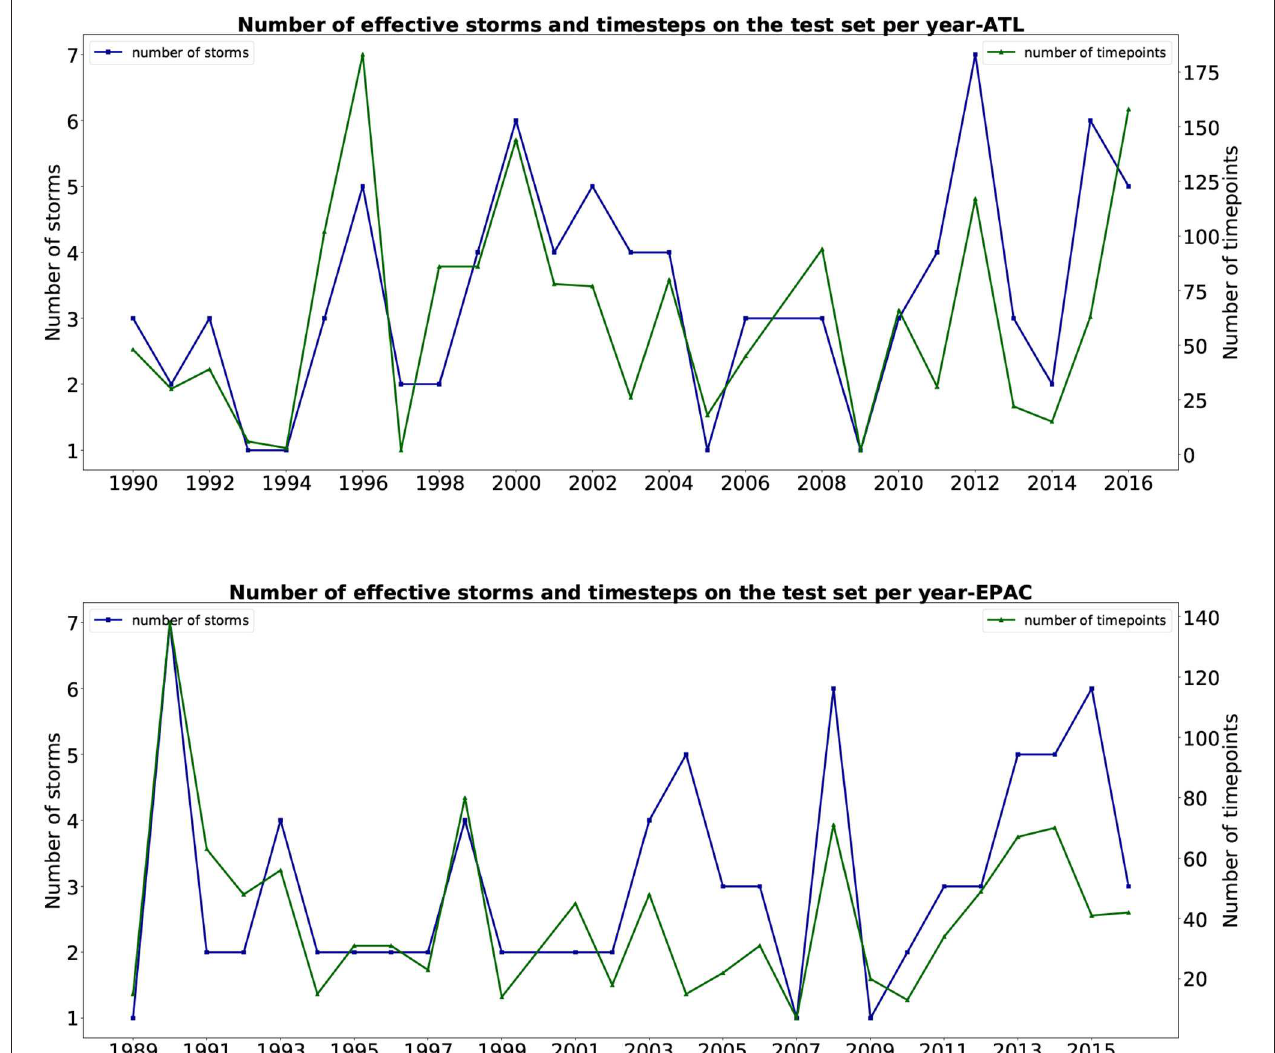
FIGURE 7 | Number of storms and timesteps used to compare in the two basins (Atlantic and East Pacific) for every year,